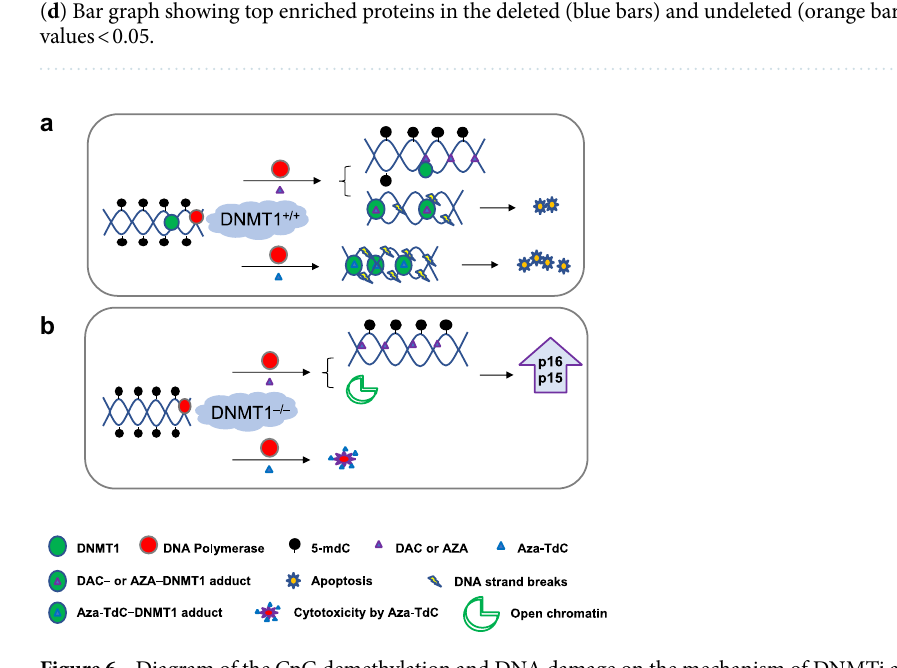
Figure 6. Diagram of the CpG demethylation and DNA damage on the mechanism of DNMTi anticancer activity (DNA damage and apoptosis). ( a ) In DNMT1 +/+ cells, the incorporation of DAC or AZA into DNA (1) inhibits DNMT1 function and causes DNA demethylation upon replication, and (2) forms the drug-DNMT1 adduct that produces DNA strand breaks and subsequent apoptosis. The incorporation of aza-TdC into DNA forms the drug-DNMT1 adduct that generates severe DNA damage, predominantly triggering apoptosis. ( b ) In DNMT1 −/− cells, the incorporation of DAC or AZA into DNA causes demethylation during DNA replication and open chromatin in the absence of DNMT1, leading to the re-expression of tumor suppressors; aza-TdC generates the cytotoxicity. 5-mdC 5-Methyl- 2’-